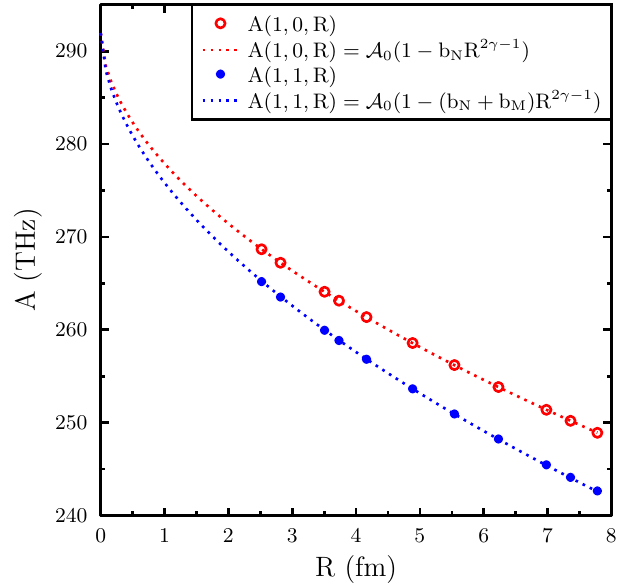
Figure 1. Dependence of the HFS constant A ( g I , d nuc , R ) for the ground state of H-like Fr ion on the nuclear radius for g I = 1. Dots and circles correspond to the calculated values. Dashed lines correspond to the fits by Equations (5) and (6). Dots: both BR and BW corrections are taken into account; circles: BW correction is equal to